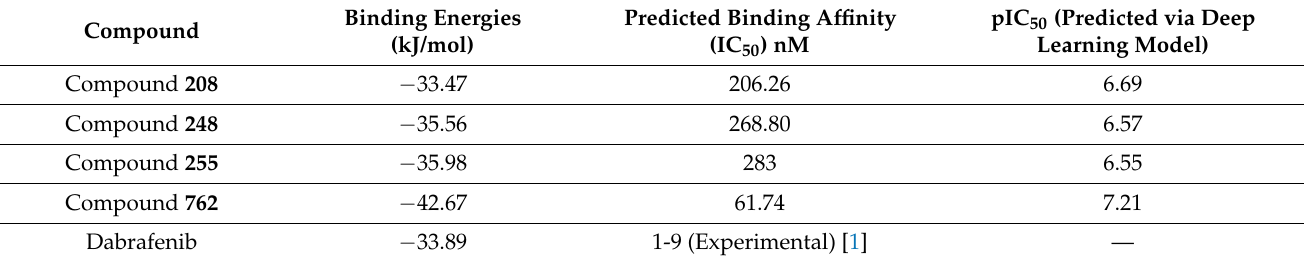
Table 4. Binding energies and Predicted binding affinities via Deep learning